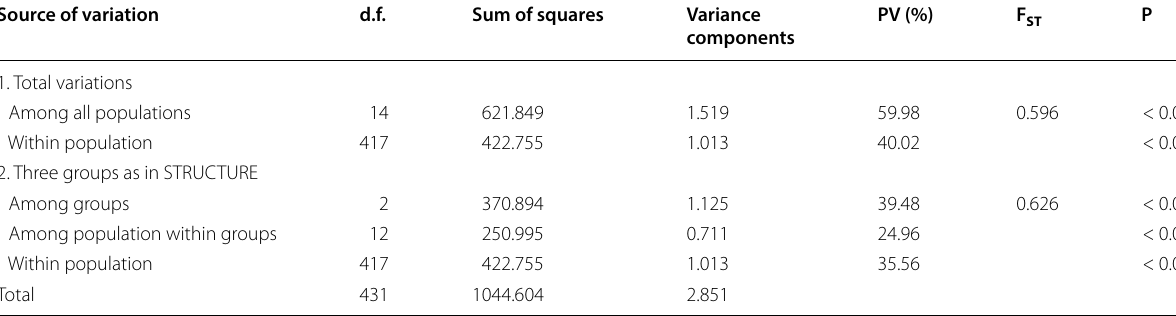
Table 3 Analysis of molecular variance (AMOVA) for the 15 N. nucifera populations